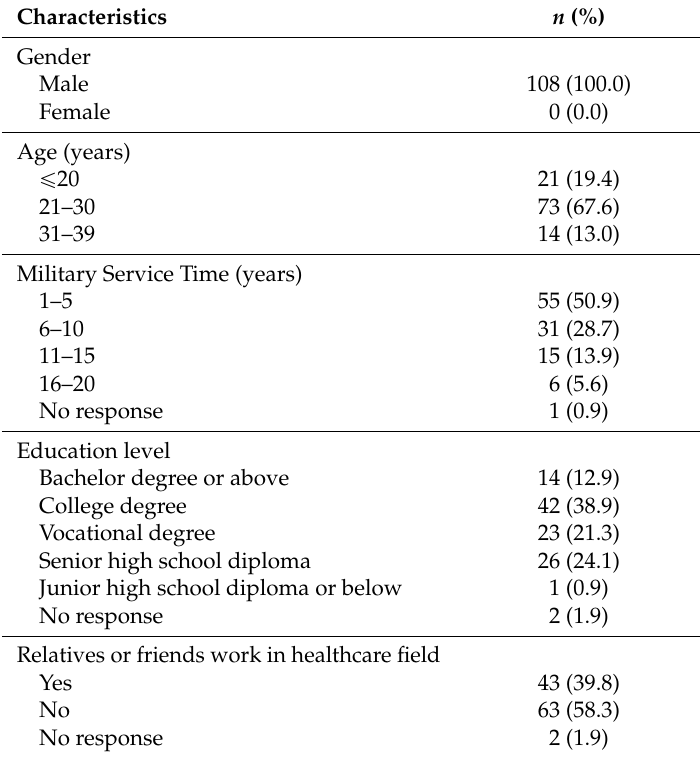
Table 1. Socio-demographic characteristics of respondents ( n =